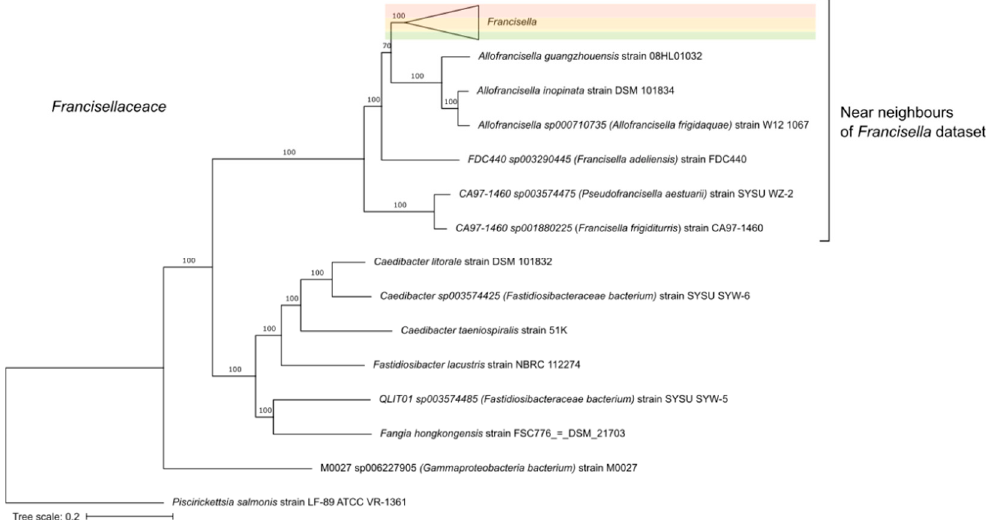
Figure A1. Phylogenetic tree of family Francisellaceae .